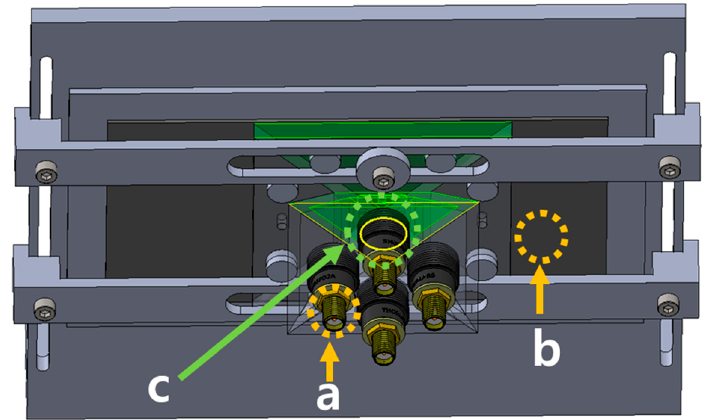
Figure 8. Architecture of the pixel luminance change detector: ( a ) a photosensor, ( b ) an HMD panel, and ( c ) a chamber.